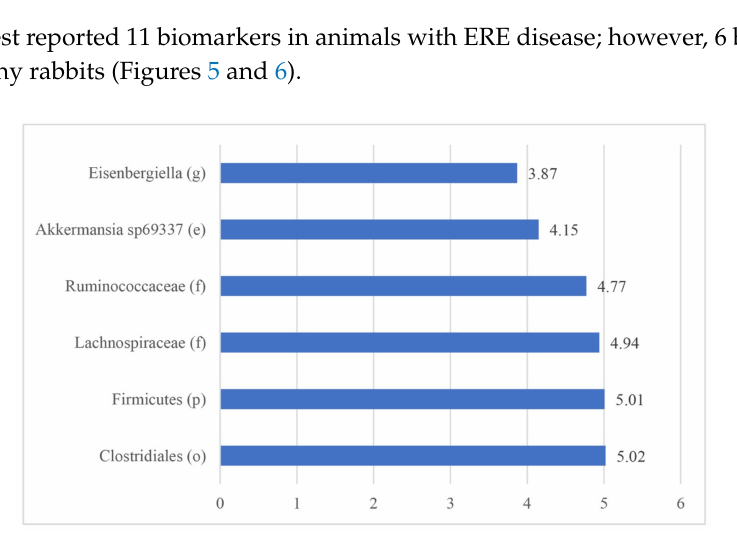
Figure 6. Biomarkers identified using the LEfSe test in healthy rabbits. (f): family, (e): species, (o): order, (g): genus, (p):